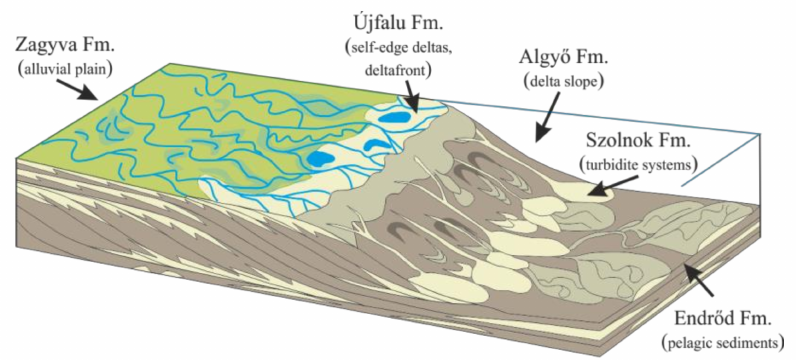
Figure 2. Schematic model of the Late Miocene, Pliocene prograding delta system with the deposi- tional environments and the deposited lithostratigraphic units (modified after [38]).